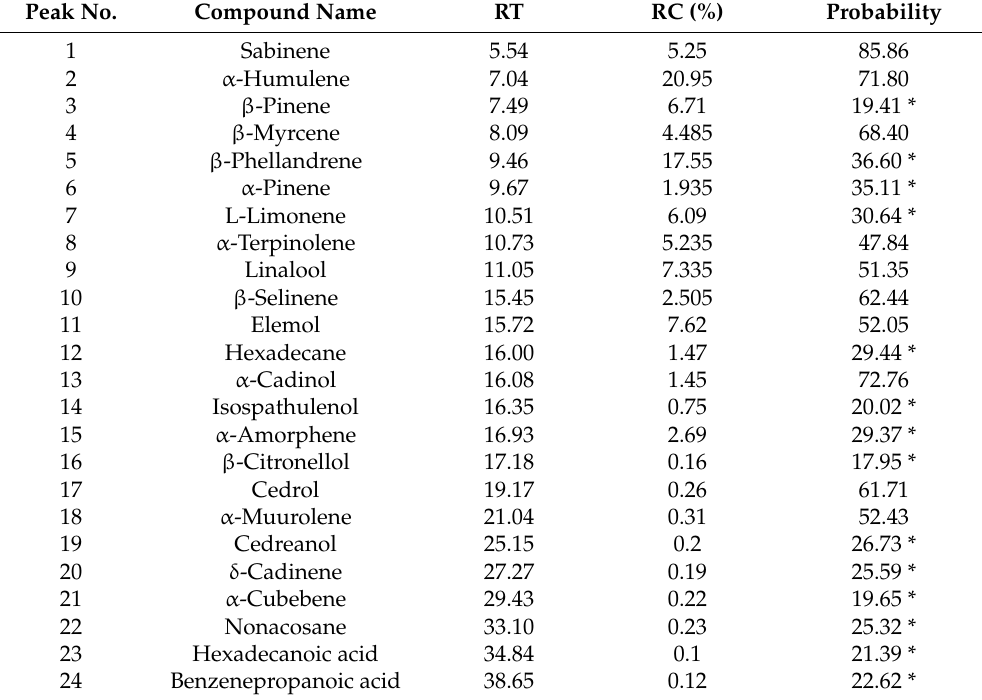
Table 1. GC/MS analysis of Juniperus phoenicea leaf extract. Peak No.